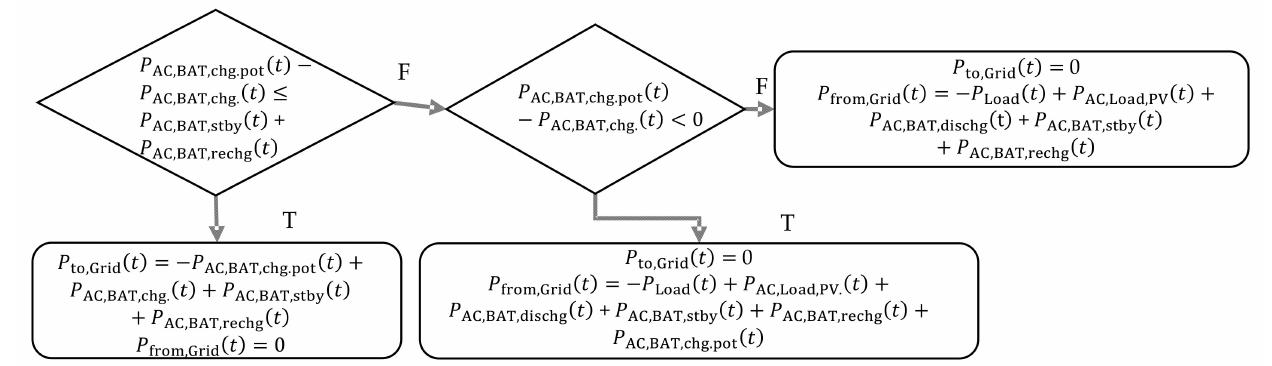
Figure 6. Calculation of the grid consumption and the grid feed-in—T stands for true and F for false. AC standby power can either occur when the battery is empty or when it is full